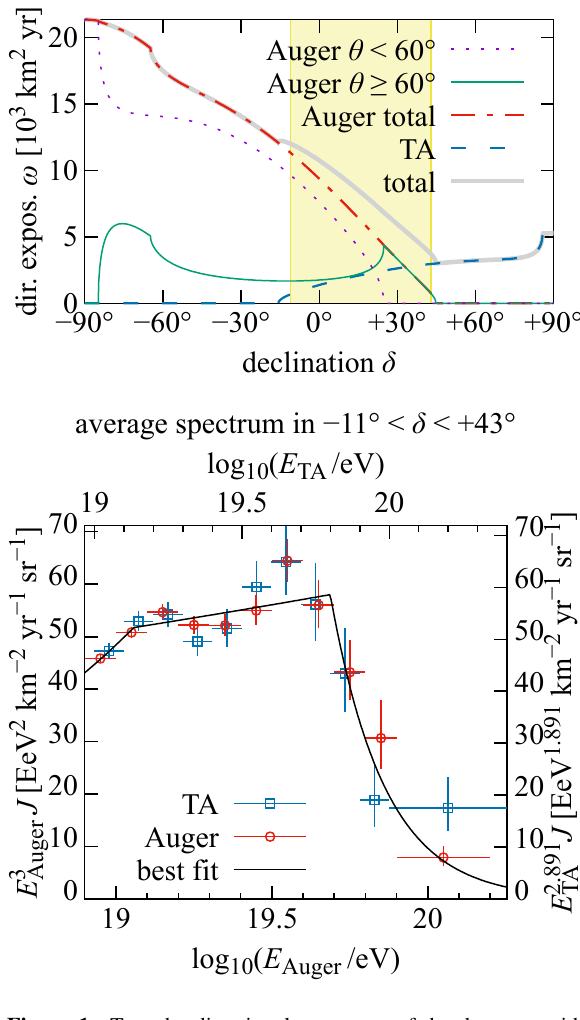
Figure 1. Top: the directional exposures of the datasets, with the declination band used for the energy cross-calibration high- lighted. Bottom: the energy cross-calibration fit ( χ 2 / n dof = 20 . 7 / 14; p = 0 .